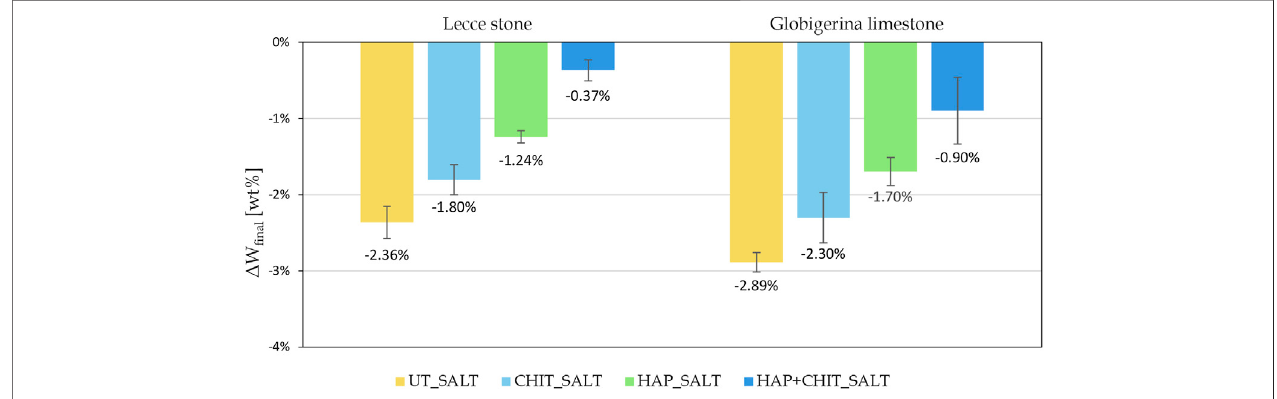
FIGURE 5 | Change in the fi nal dry weight, after brushing, compared to the initial weight of the cylindrical samples.